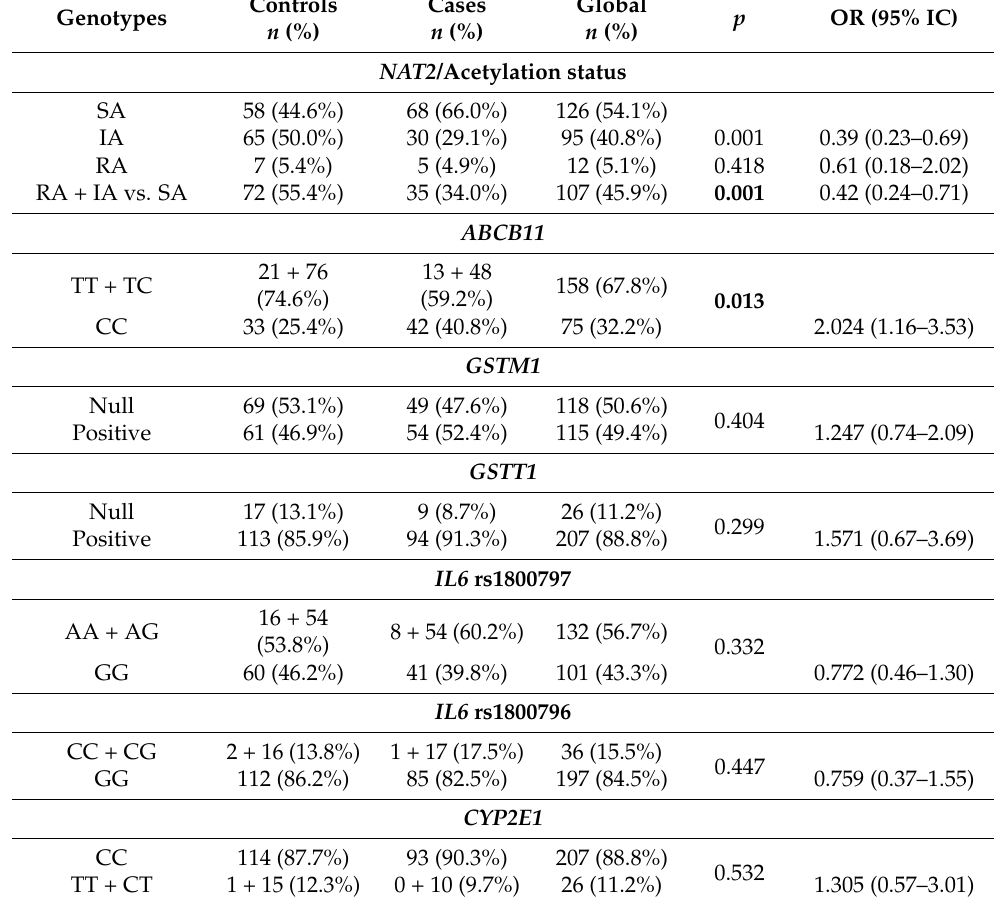
Table 3. Characterization of genetic risk factors.